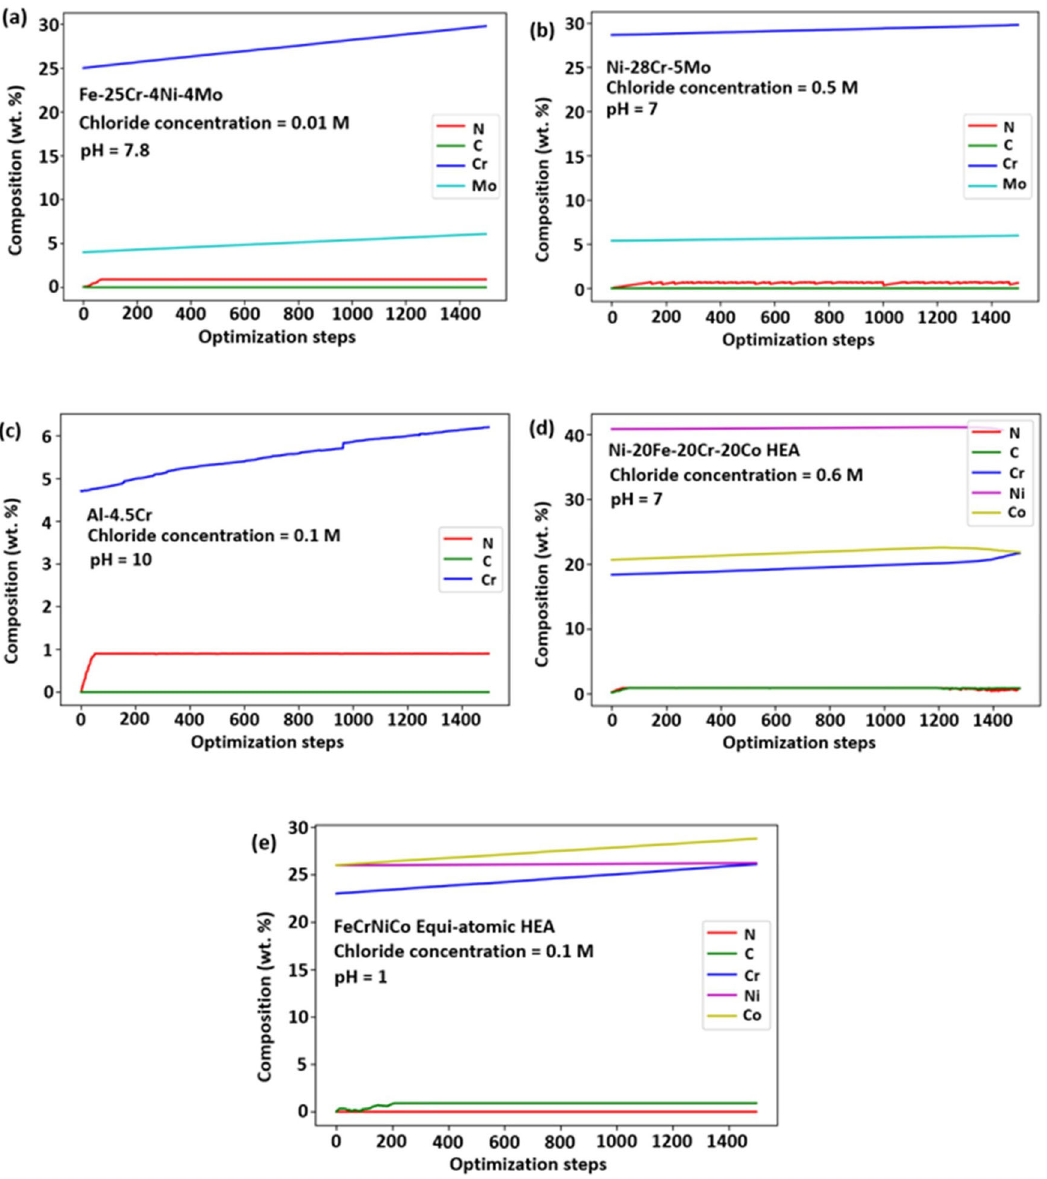
Fig. 4 Compositional change during different optimization sequences carried out while keeping the test-speci fi c parameters fi xed and not allowing N or C composition extrapolation beyond the training data. The initial conditions for each optimization sequence have been indicated. a Fe-25Cr-4Ni-4Mo ferritic stainless steel. b FCC Ni-28Cr-5Mo alloy. c Al-4.5Cr alloy. d FCC Ni-20Fe-20Cr-20Co high entropy alloy and e FCC equiatomic Fe-Ni-Cr-Co high entropy